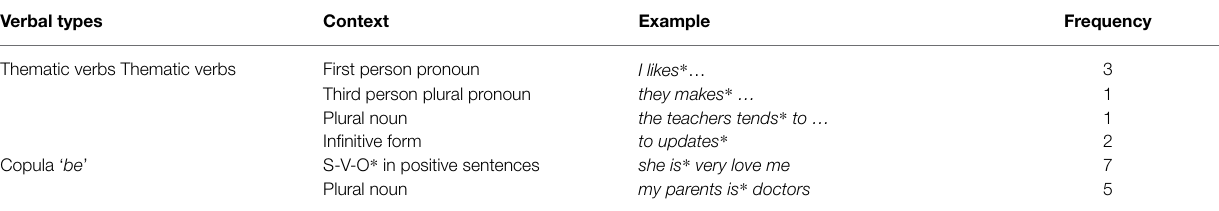
TABLE 2 | Incorrect uses of 3SG verbal inflections in the spoken